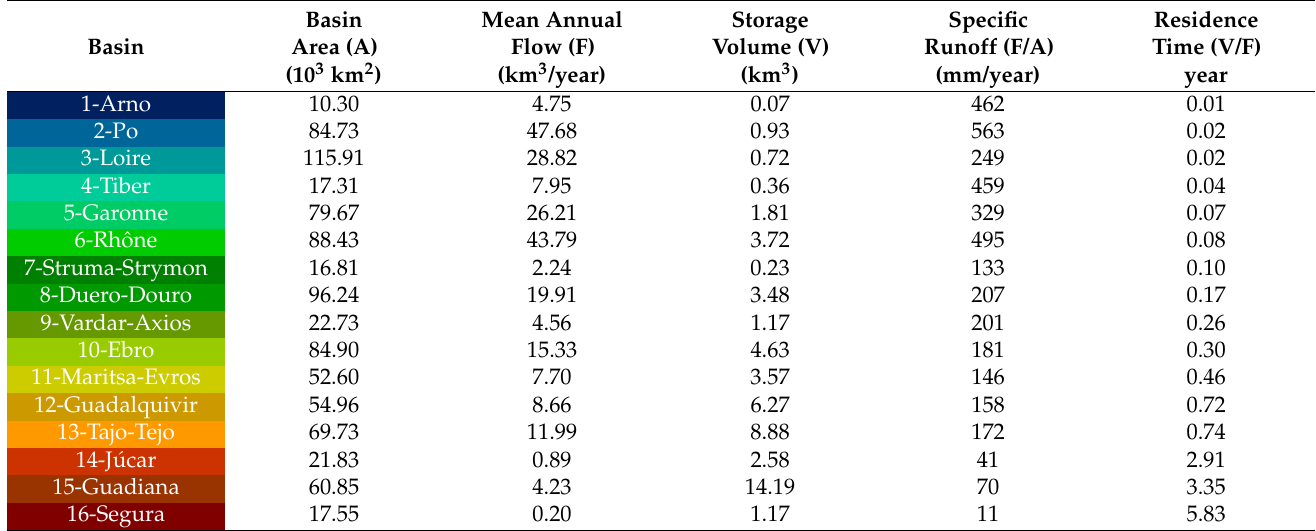
Figure 1. Southern European basins considered in this study. Table 1. Basic characteristics of the basins analyzed in this study.